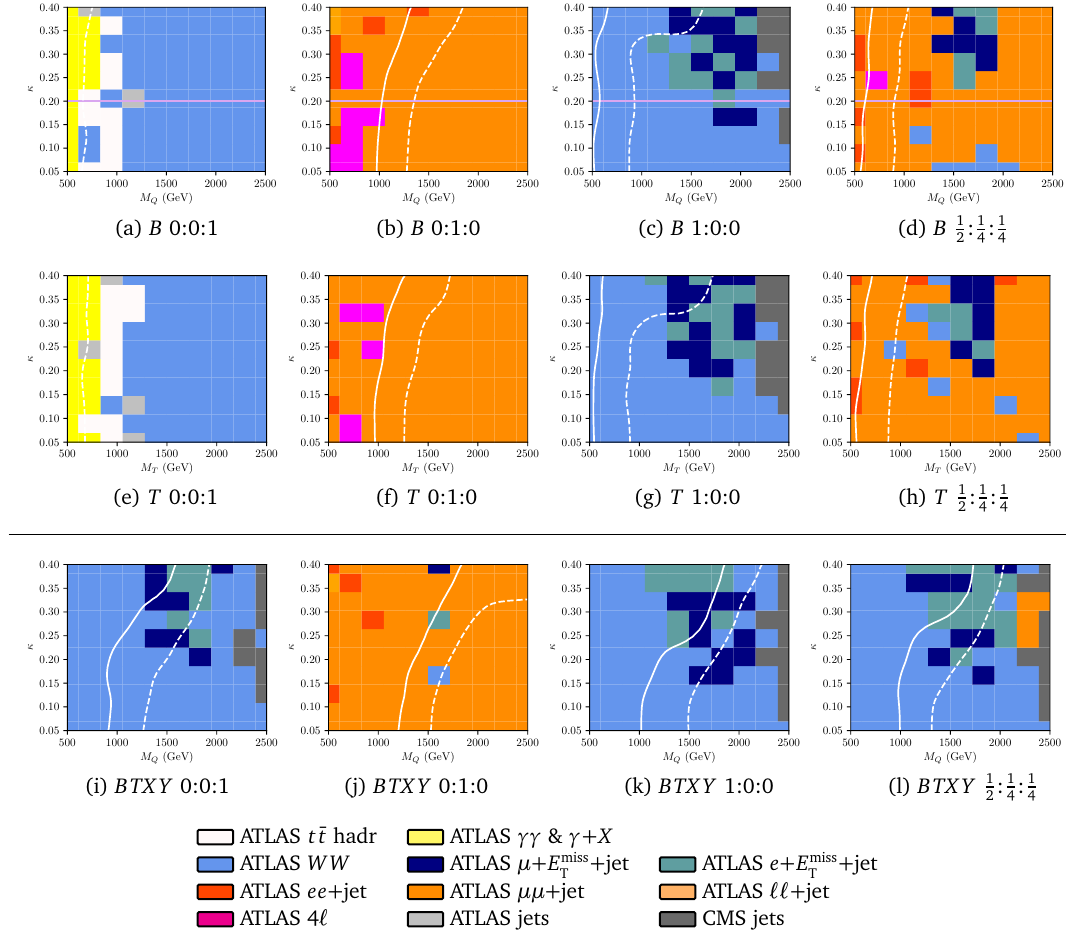
Figure 16: Sensitivity of LHC measurements to VLQ singlet production in the κ vs VLQ mass plane, where κ is the coupling to second-generation SM quarks. All VLQ masses are set to be degenerate. The multiplets are given as rows: (a)–(d) B singlet, (e)–(h) T singlet, and for comparison to the main text, the (i)–(l)( B , T , X , Y ) quadruplet. The VLQ branching fractions to W : Z : H are arranged in columns of 0:0:1, 0:1:0, 1:0:0, : 1 : 1 from left to and 1 2 4 4